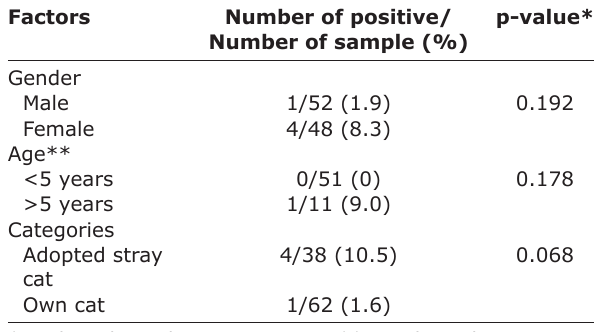
Table-2: Analysis of factors associated with Toxoplasma seropositive.